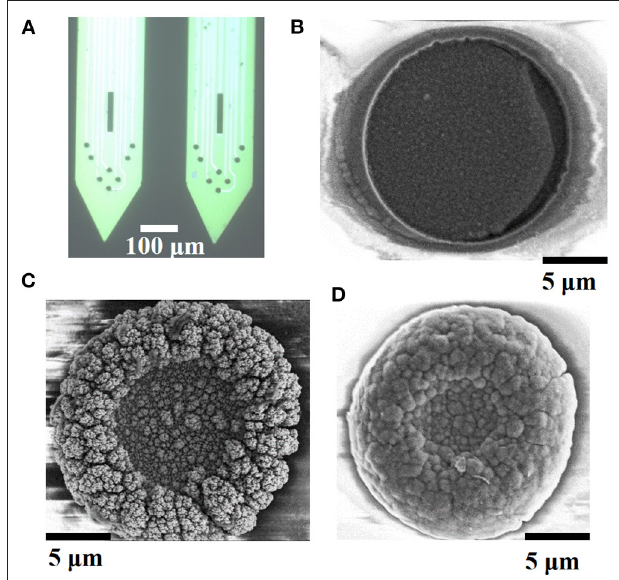
FIGURE 3 | Electrode modification topography. (A) Microscopic image of modified PtNPs/PEDOT:PSS electrode. The morphology of (B) PEDOT:PSS, (C) PtNPs, and (D) PtNPs/PEDOT:PSS modification schemes under scanning electron microscope.